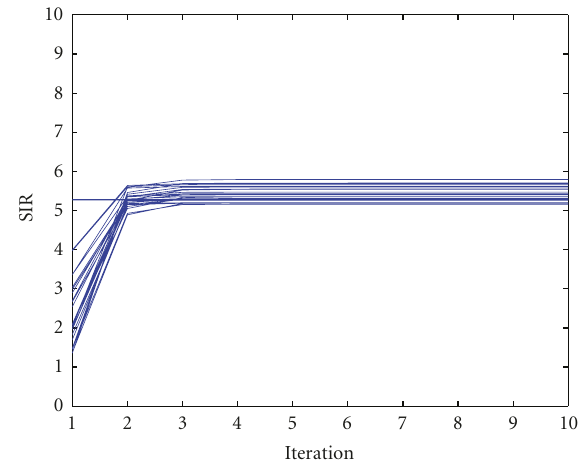
Figure 12: Uplink individual user SIR convergence for Gaussian = 0 . 001, γ = 5 . channel estimation error σ 2 h